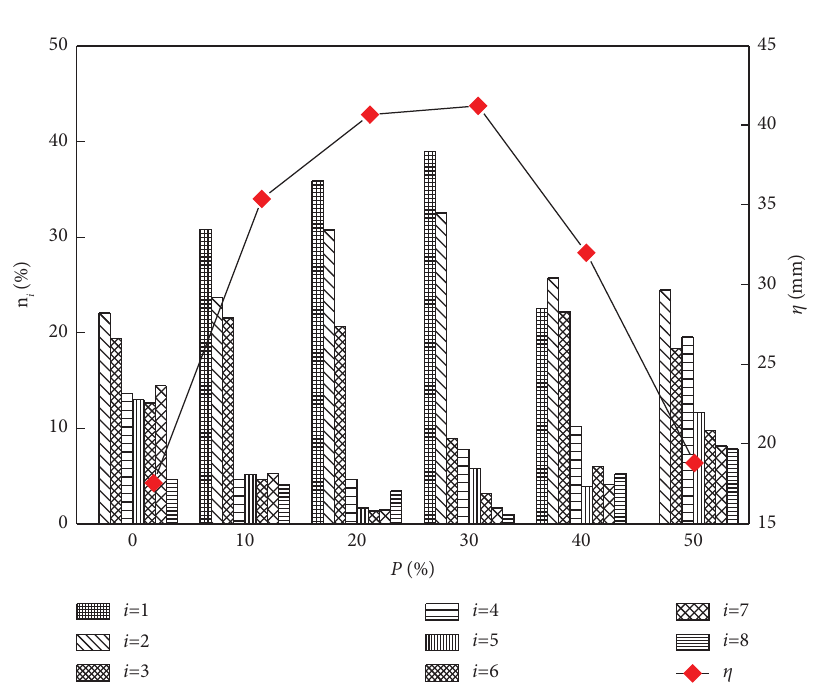
Figure 11: Fragment distribution of concrete with diferent fy ash